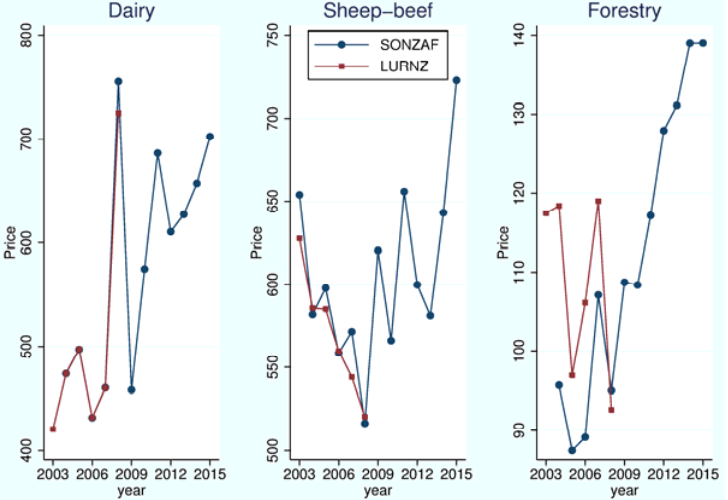
Figure A1. A comparison of observed prices as used in the econometric estimation of price responsiveness (LURNZ) and as reported by SONZAF, as well as SONZAF price